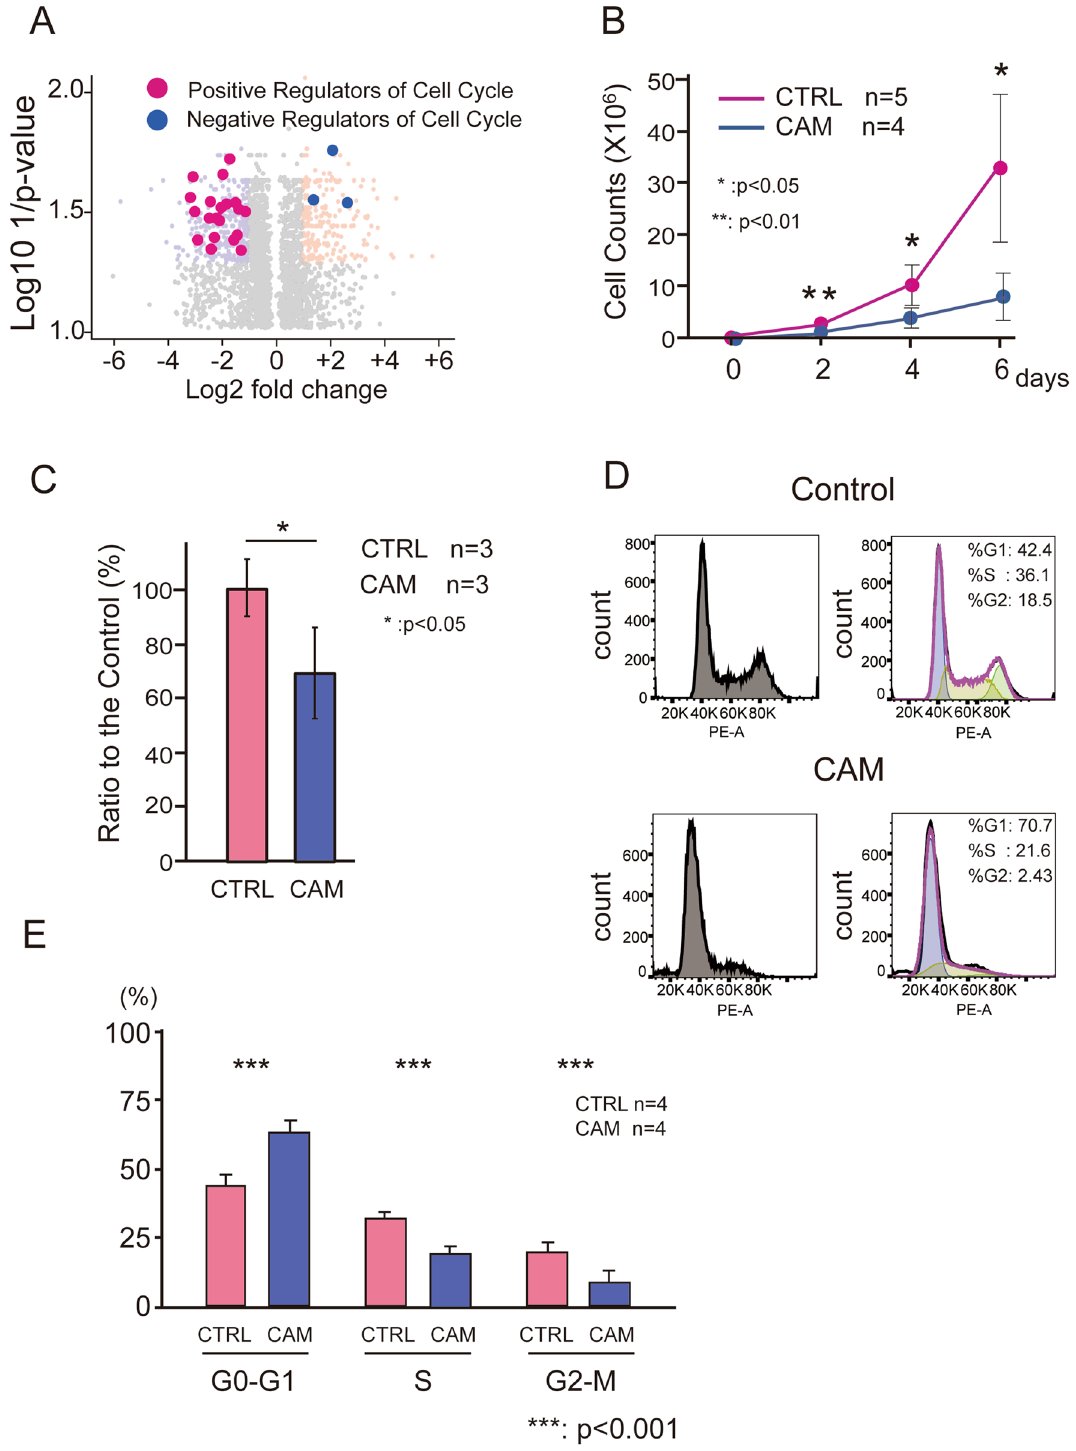
Figure 3. ( A ): Genes related positive regulation of cell cycle (red), and negative regulation of cell cycle (blue) were plotted on the volcano plot. ( B ): Cell proliferation assay. We passaged the cells three times every 2 days (days 2, 4, and 6) and counted the number of the cells at each passage. (control: n = 5, CAM: n = 4) * p < 0.05, ** p < 0.01, Error bars indicate ± SE. Student’s t test was used for statistical analysis. ( C ): MTS assay of UCMSCs statistically revealed the significant difference between the control (n = 3) and the CAM group (n = 3). * p < 0.05, Error bars indicate ± SE. Student’s t test was used for statistical analysis. ( D ): Representative data of the cell cycle distribution of the UCMSCs from the control and the CAM group. Compared with the control group, the cells in G2/S phase were decreased in the CAM group. ( E ): A comparison of the UCMSCs population at each phase of the cell cycle revealed the significant difference between the control (n = 4) and the CAM group (n = 4), *** p < 0.001, Error bars indicate ± SE. Student’s t test was used for statistical